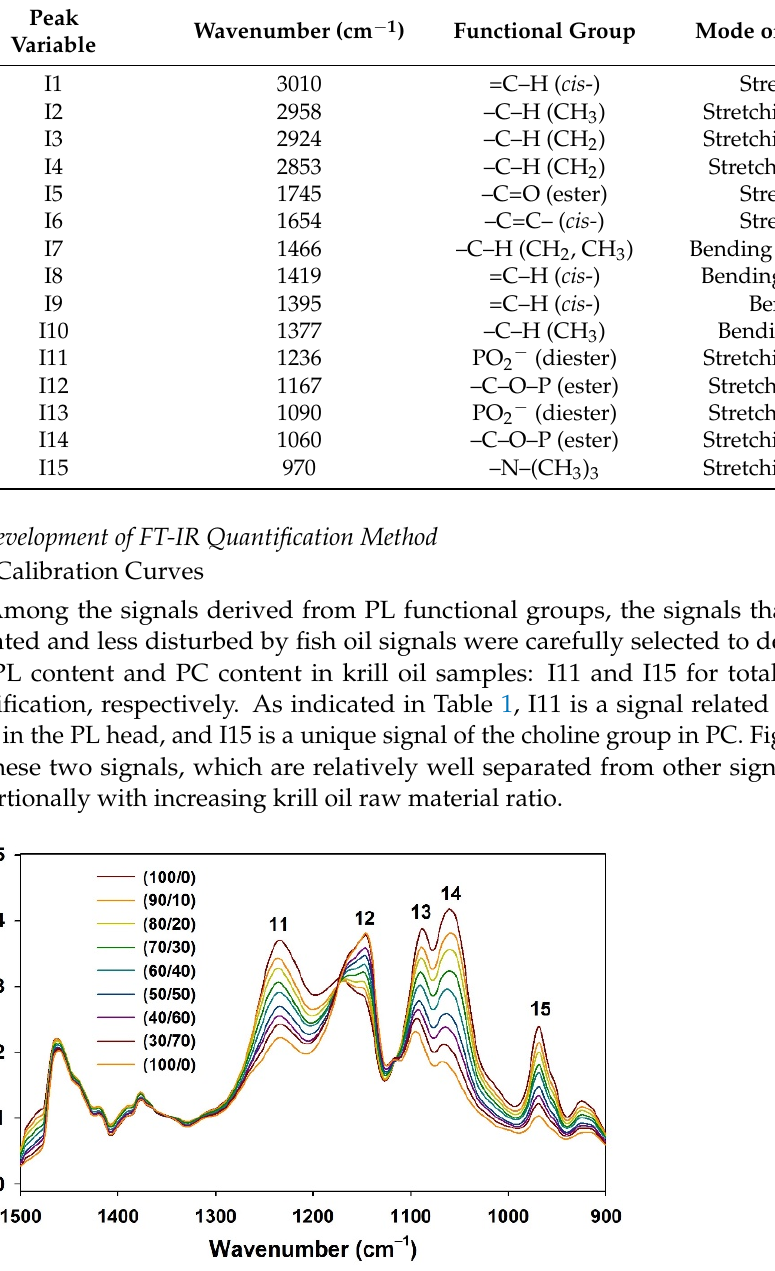
Figure 2. FT-IR spectra of mixed samples of krill oil raw material and fish oil with a ratio of krill oil/fish oil from 20/80 to 100/0 ( w / w %) in the region of 1500–900 cm − 1